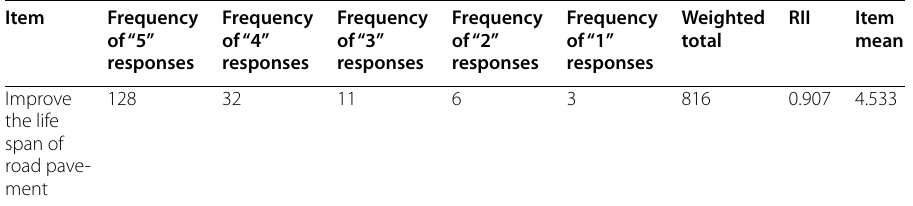
Table 5 Problems after construction work ( n